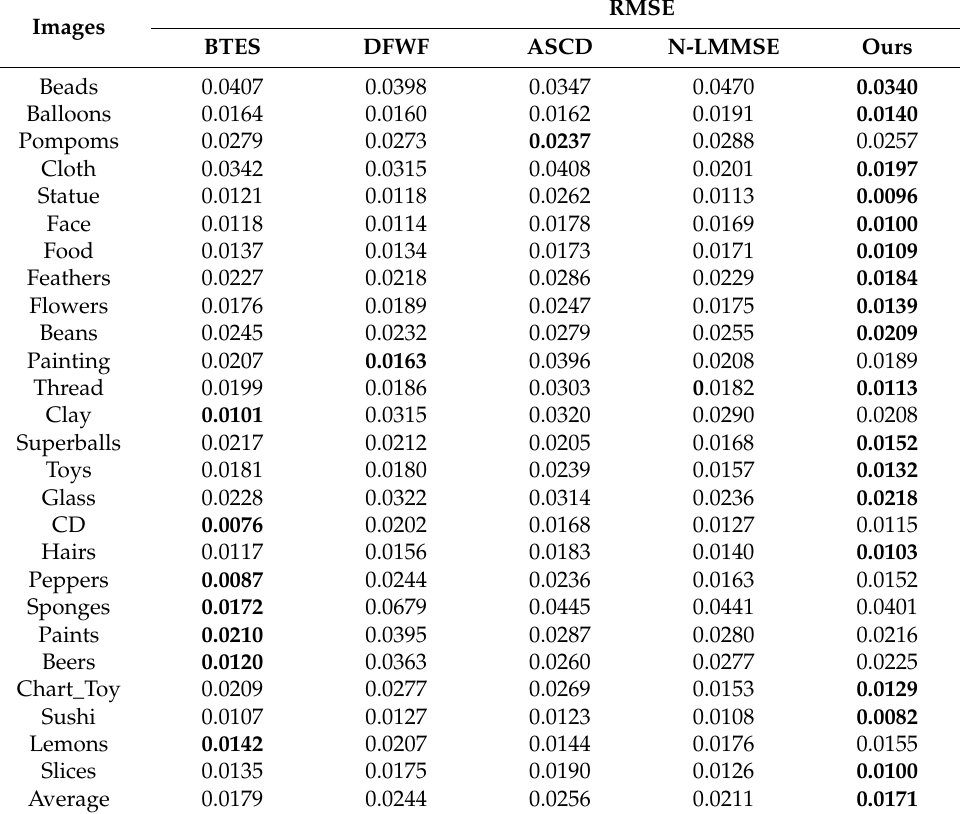
Table 4. The RMSE average results of demosaicking